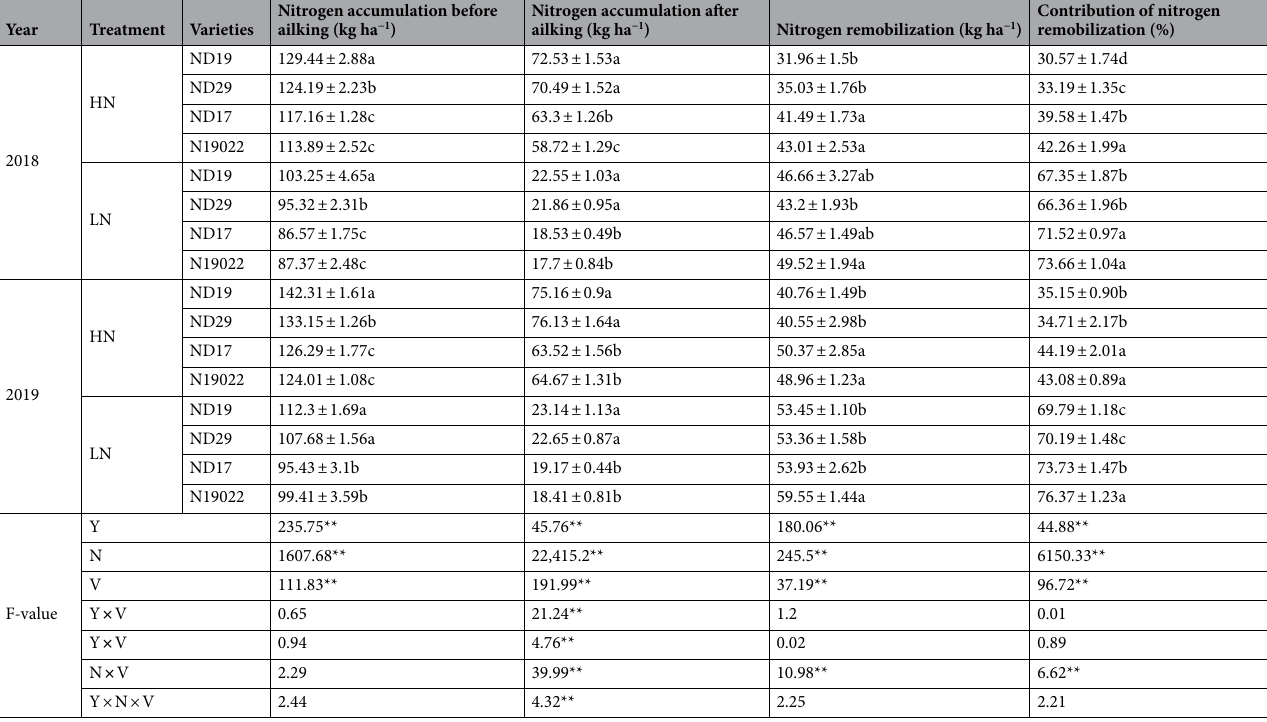
Table 2. Post-silking nitrogen accumulation and remobilization of the four varieties under different nitrogen rate. HN high nitrogen conditions, LN low nitrogen conditions. **F values significance at 0.05 and 0.01 probability levels, respectively. Different letters represent significant differences among